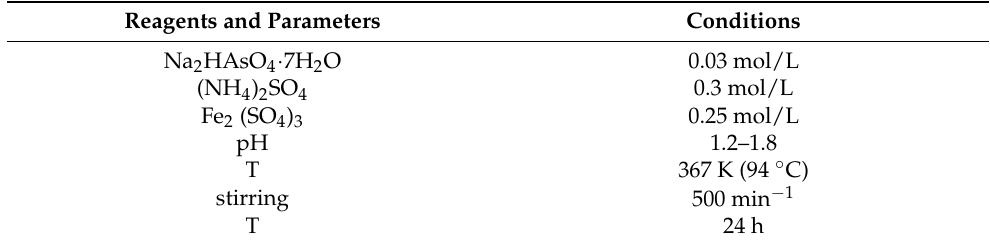
Table 1. Parameters and conditions for the synthesis of NH 4 -Na jarosite with arsenic. Reagents and